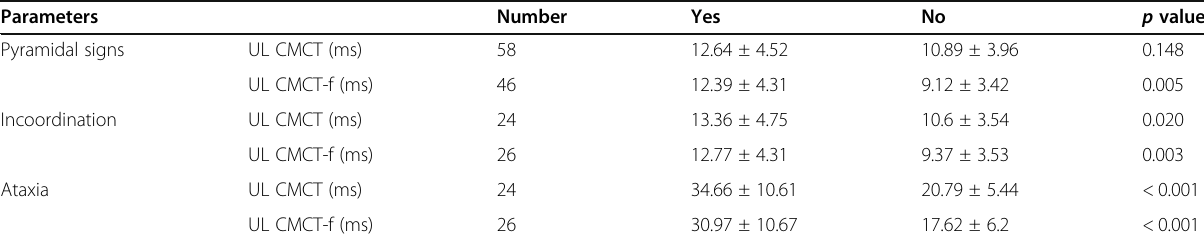
Table 4 CMCT in patients with multiple sclerosis with and without upper limb pyramidal signs, incoordination, and ataxia